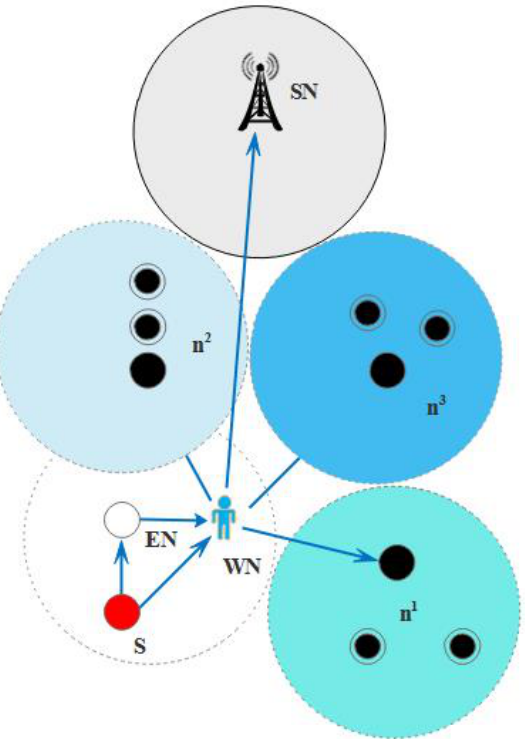
Figure 8. Possible transmission adjustment of Watchman Node (WN) with Empty Node (EN ).